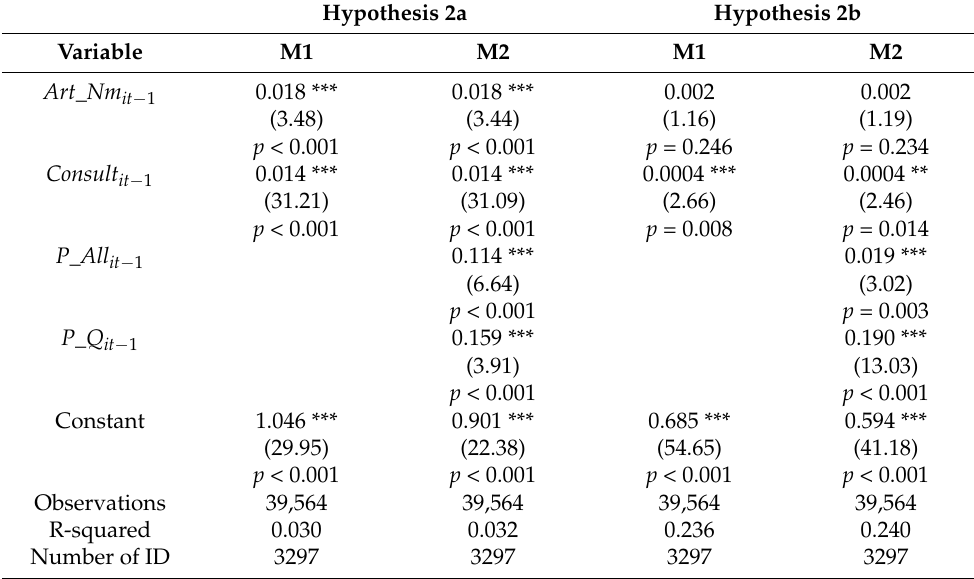
Table 3. Two-way fixed effect of Hypothesis